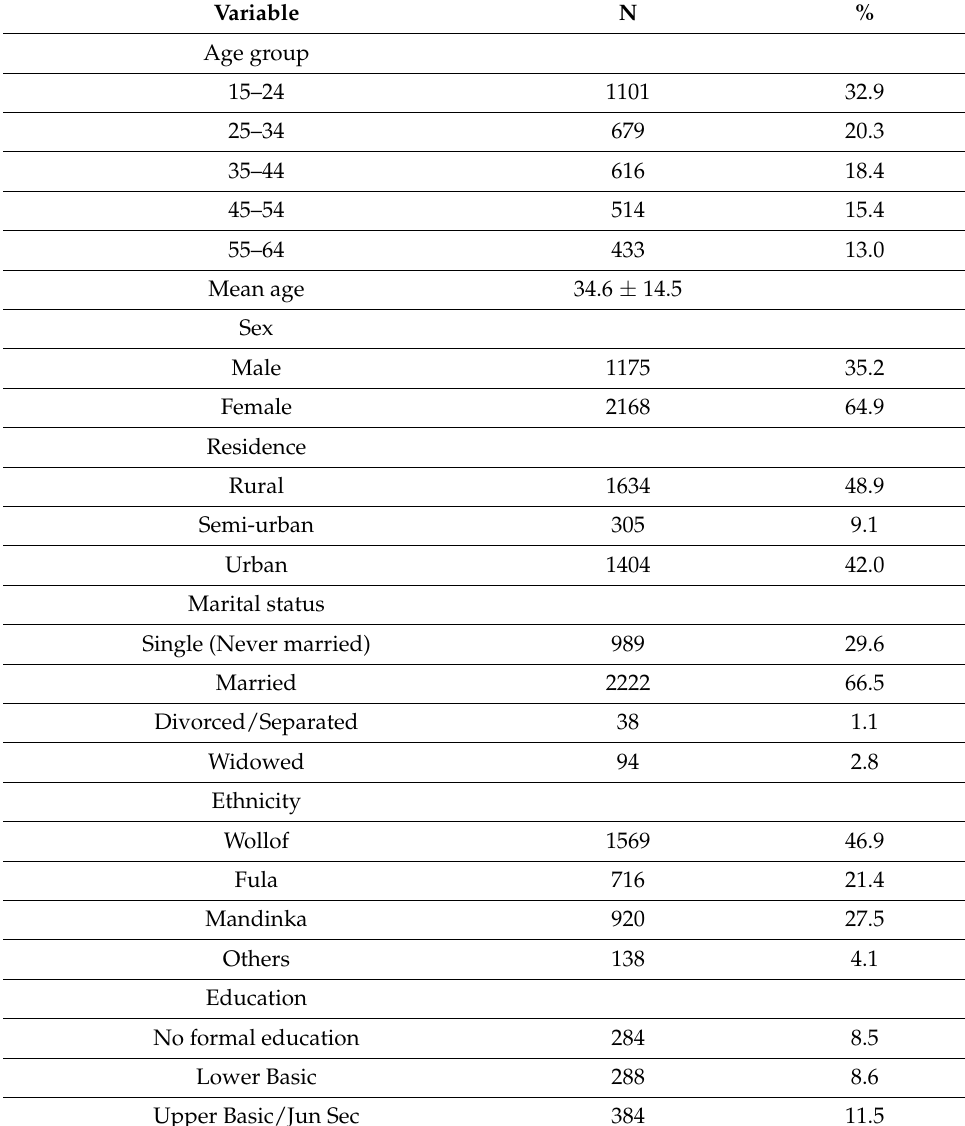
Table 1. Characteristics of study participants ( n =